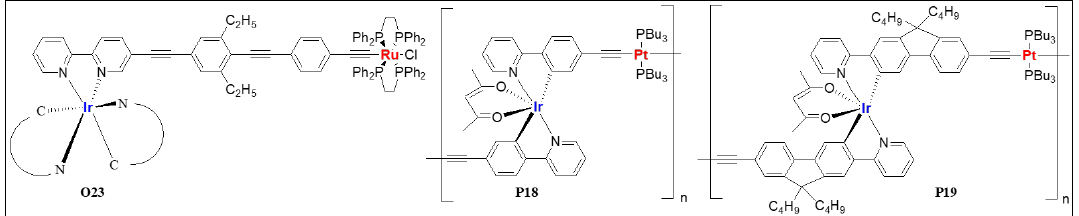
Figure 14. Heterometallic poly-ynes ( O23 , P18 and P19 ) for NLO and OLED applications.